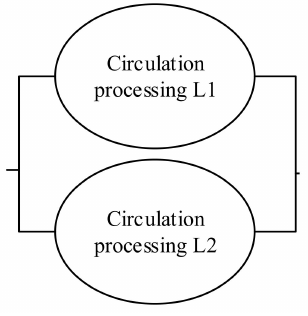
Figure 3. Structural diagram of a typical parallel logistics system.